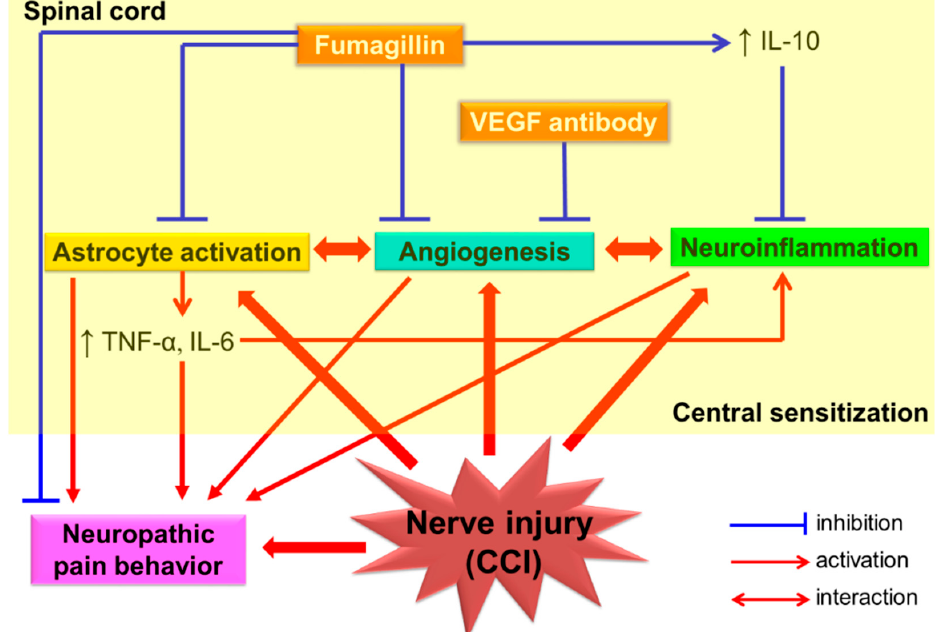
Figure 9. Schematic representation of the proposed mechanism for the anti-nociceptive effect of intrathecal fumagillin on spinal neuroinflammation and central sensitization in a rat model of chronic constriction injury (CCI) − induced neuropathic pain. Abbreviation: CCI, chronic constriction injury; IL, interleukin; TNF − α , tumor necrosis factor − α ; ↑ , upregulation.